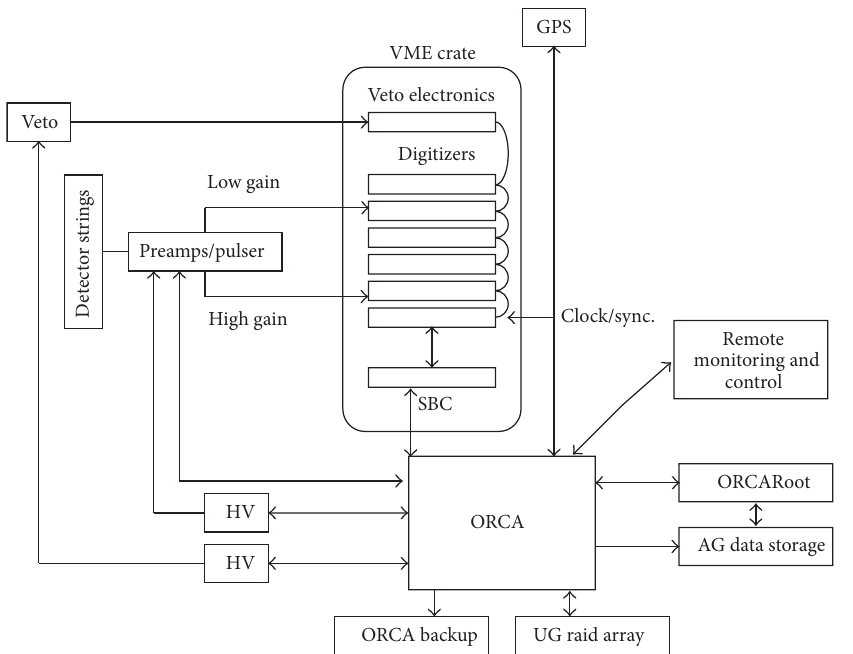
Figure 8: A high-level schematic of the DAQ system. Each detector uses a low- and a high-gain digitizer channel for a total of 70 channels per crate. Each VME crate has one single-board computer (SBC) that reads out all electronics in its crate, sending the resulting data to ORCA. Data is buffered locally underground and then transferred to the surface. There will be one VME crate per module. The veto electronics will reside only in one of the two